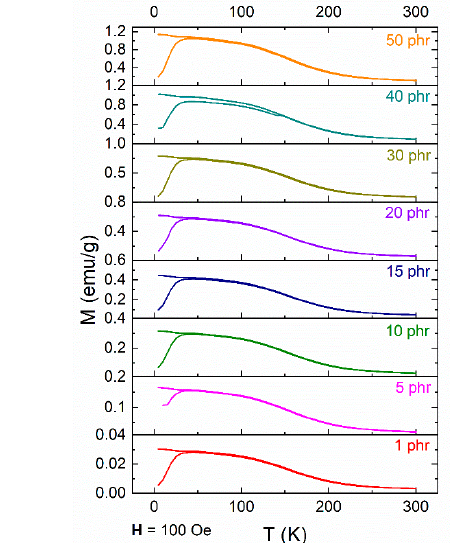
with varying ZnFe 2 O 4 filler